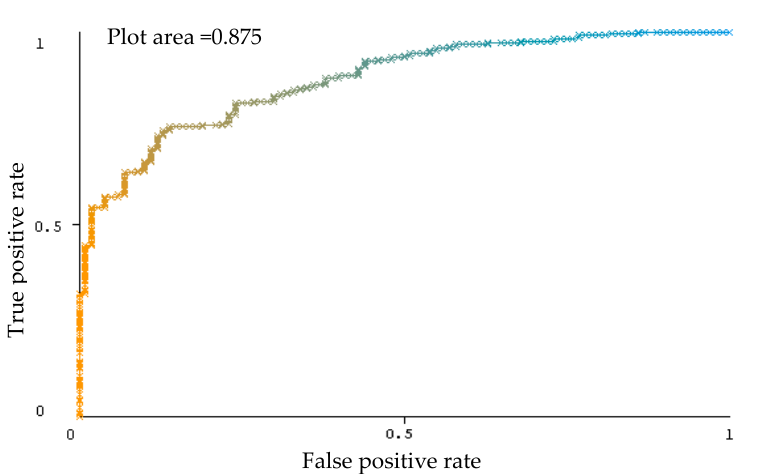
Figure 14. ROC graph activity of ensemble classifier bagging ( a ), Adaboost ( b ), random subspace ( c ) with RF classifier using 10-fold cross validation method Dataset 2.